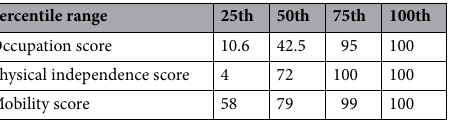
Table 2. Percentile range of the three summary scores based on